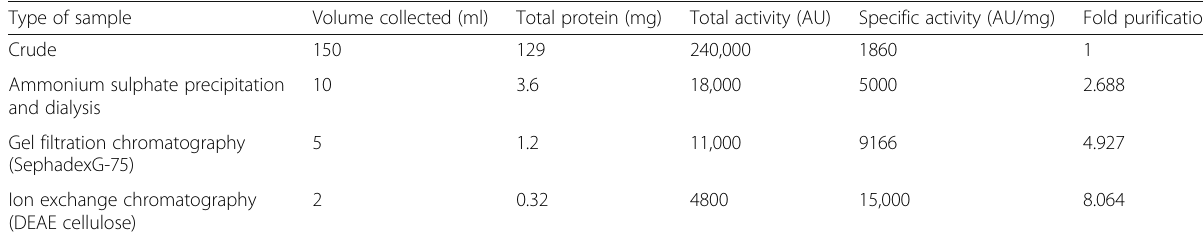
Table 1 Summary of purification profile of bacteriocin ABC transporter ATP-binding protein produced by Enterococcus casseliflavus MI001